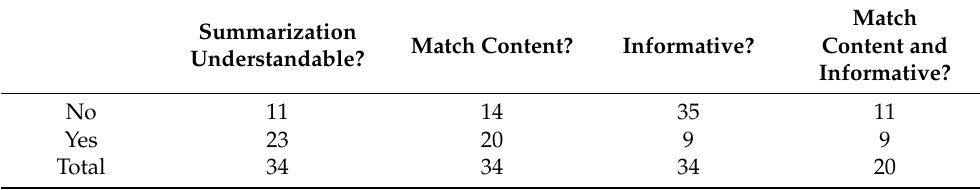
Table 3. Results evaluation B.